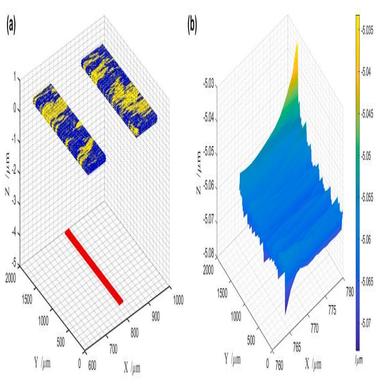
Data visualization in Experiment 2: (a) the fitting datum plane indicated by blue color; (b) false color plot of the bottom plane (in red in (a)) after subtracting the datum plane. (For interpretation of the references to color in this figure legend, the reader is referred to the Web version of this article.)